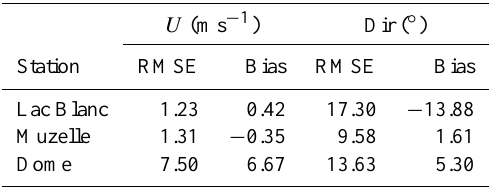
Table 2. Root-mean-square error (RMSE) and bias for wind speed, U , and direction, Dir, between simulation CTRL and measurements at three AWS located around Col du Lac Blanc (Fig. 7). Modelled wind speed was scaled to measurement height of AWS assuming a logarithmic wind profile.